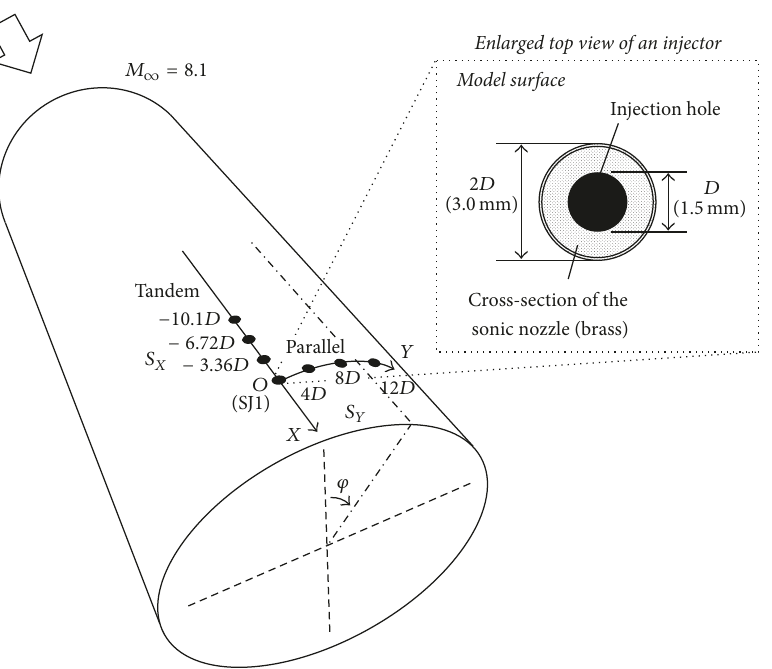
Figure 5: Injector arrangements and coordinate system along the model